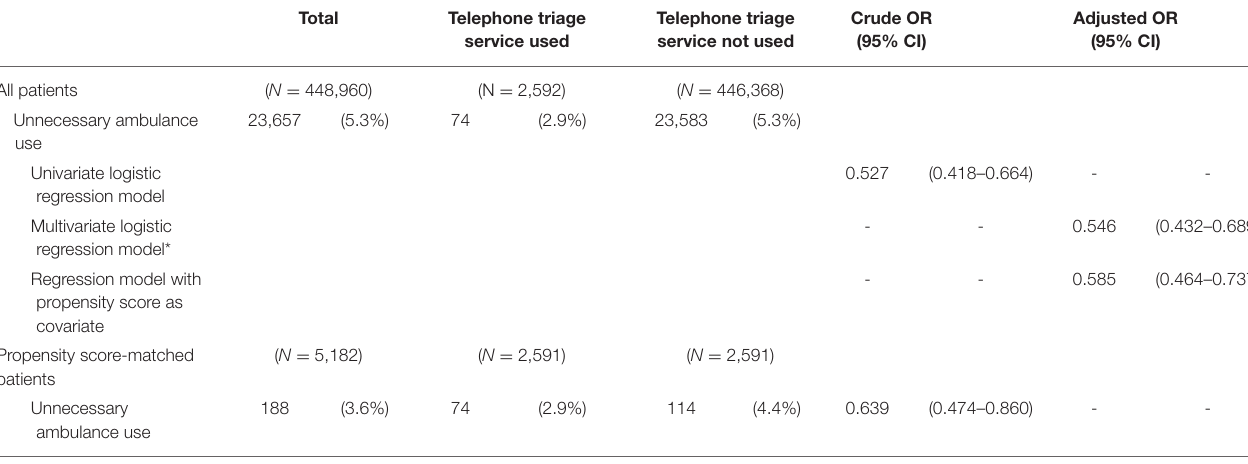
TABLE 5 | Unnecessary ambulance use with or without telephone triage service among the